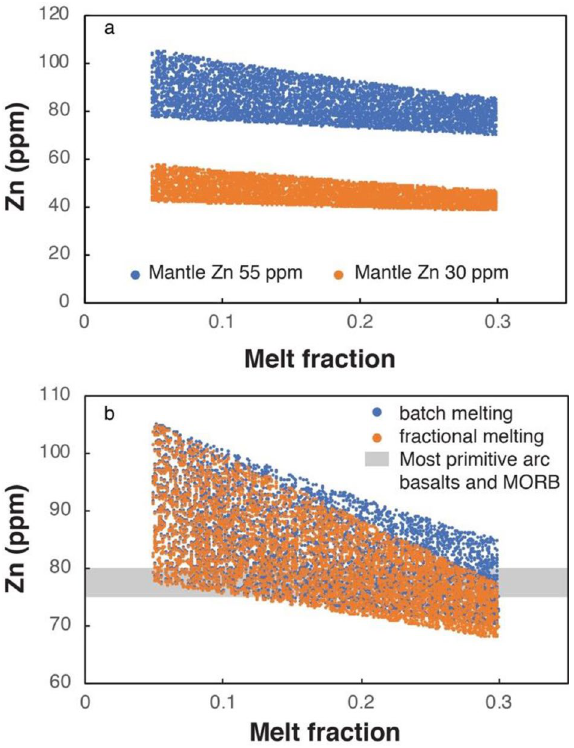
Figure 6. Zn contents of mantle-derived melts. ( a ) Zn contents of batch melting mantle-derived melts starting from mantles with different initial Zn contents (30 and 55 ppm); ( b ) Zn contents of batch melting and fractional melting mantle-derived melts starting from a mantle with 55 ppm